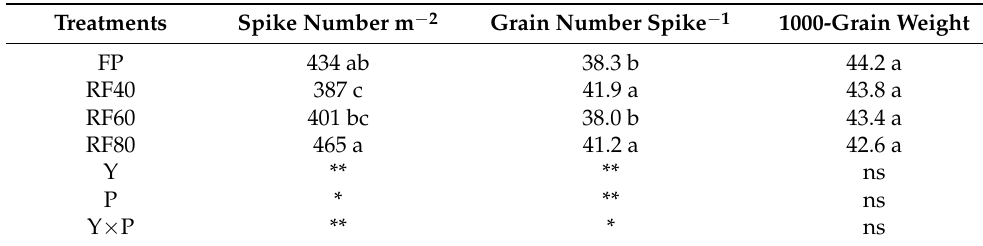
Figure A2. Seasonal variations of soil moisture at 10 cm soil depths in different planting patterns in 2017–2019. ( A ) Furrows and ( B ) ridges. Table A1. Average spike number per m 2 , grain number per spike, and 1000-grain weight (g) of winter wheat under different treatments in two growth seasons.